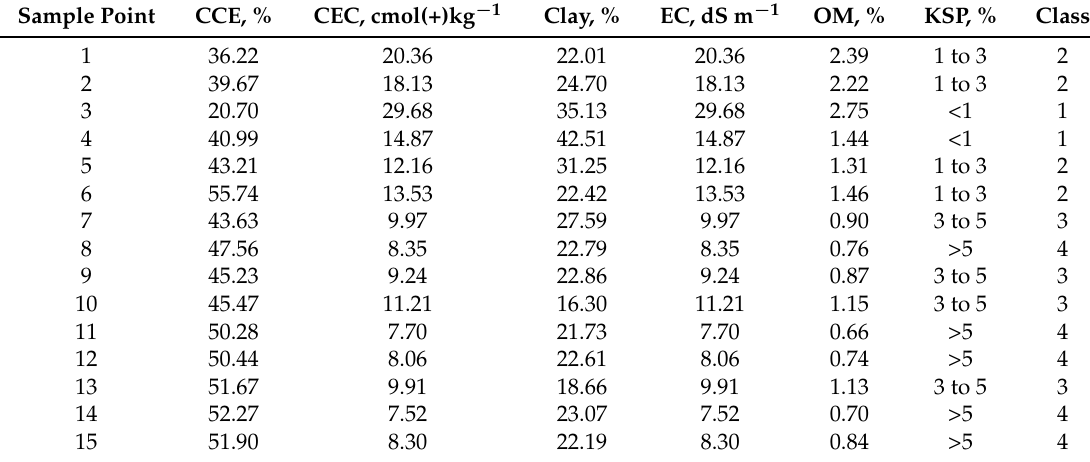
Figure 6. Position of sample points in the study area. Table 6. Characteristics of the sample points.